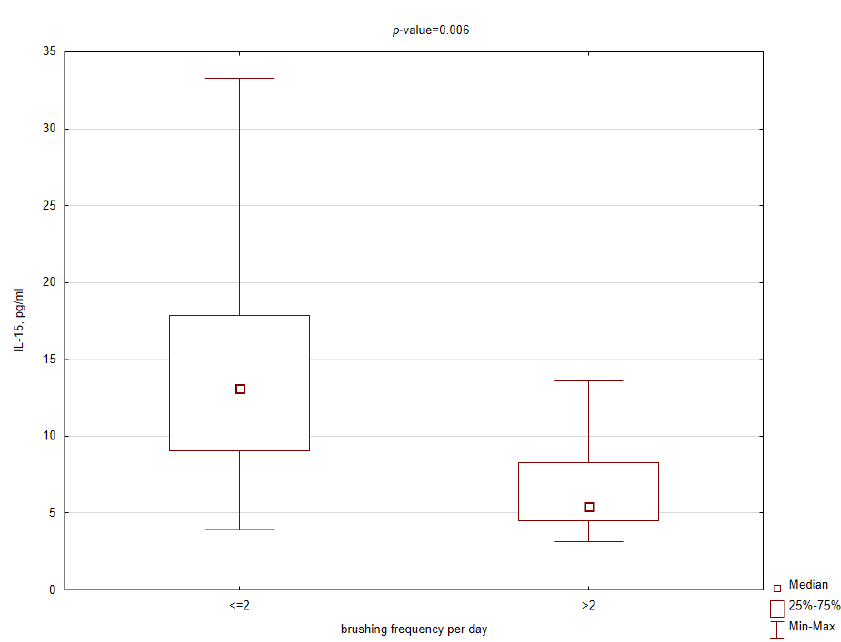
Figure 4. Box plot for salivary monocyte chemoattractant protein 1 (MCP-1) concentrations in the obese patients related to brushing frequency per day ( p -value < 0.05 according to the Mann–Whitney test).